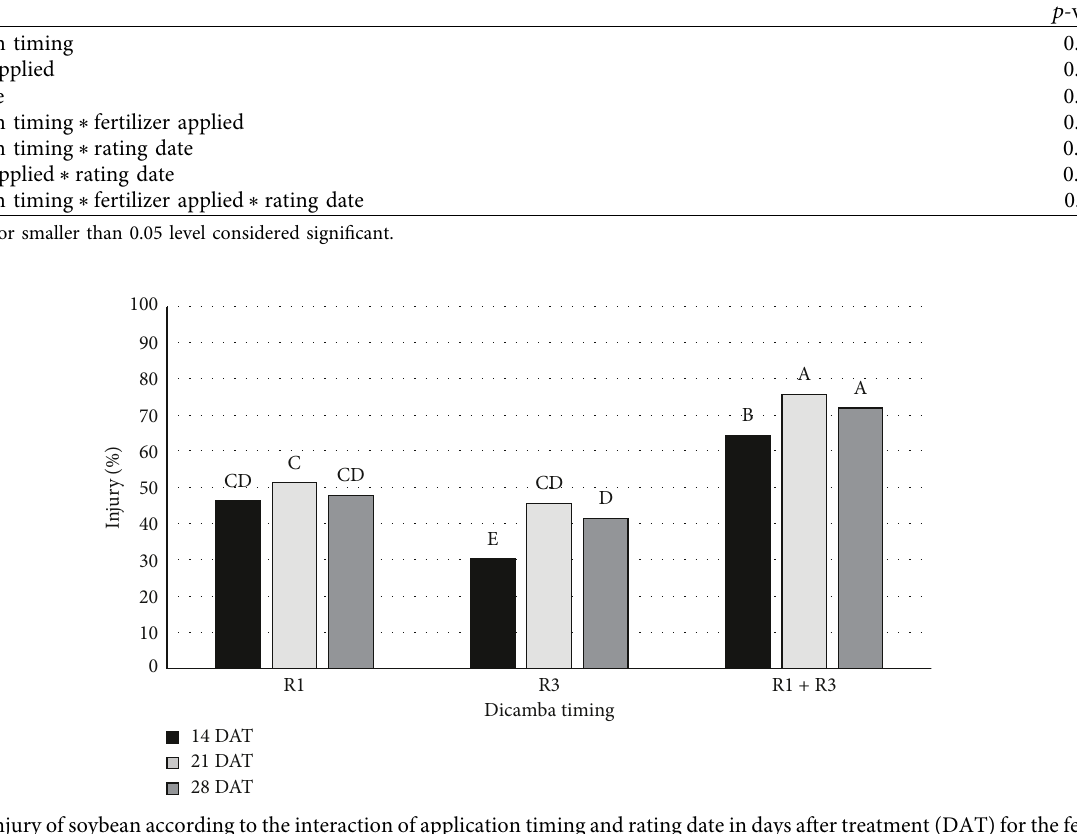
Figure 3: Injury of soybean according to the interaction of application timing and rating date in days after treatment (DAT) for the fertilizer experiment conducted in Fayetteville, AR, in 2019 and 2020. Treatments with the same uppercase letter are not significantly different according to Fisher’s protected least significant difference α 0.05. (cid:29) Table 5: The effects of application timing, fertilizer type applied, and the interaction of these effects on injury, relative biomass, seed weight, and relative yield for the experiment conducted in Fayetteville, AR in 2019 and 2020. Factors